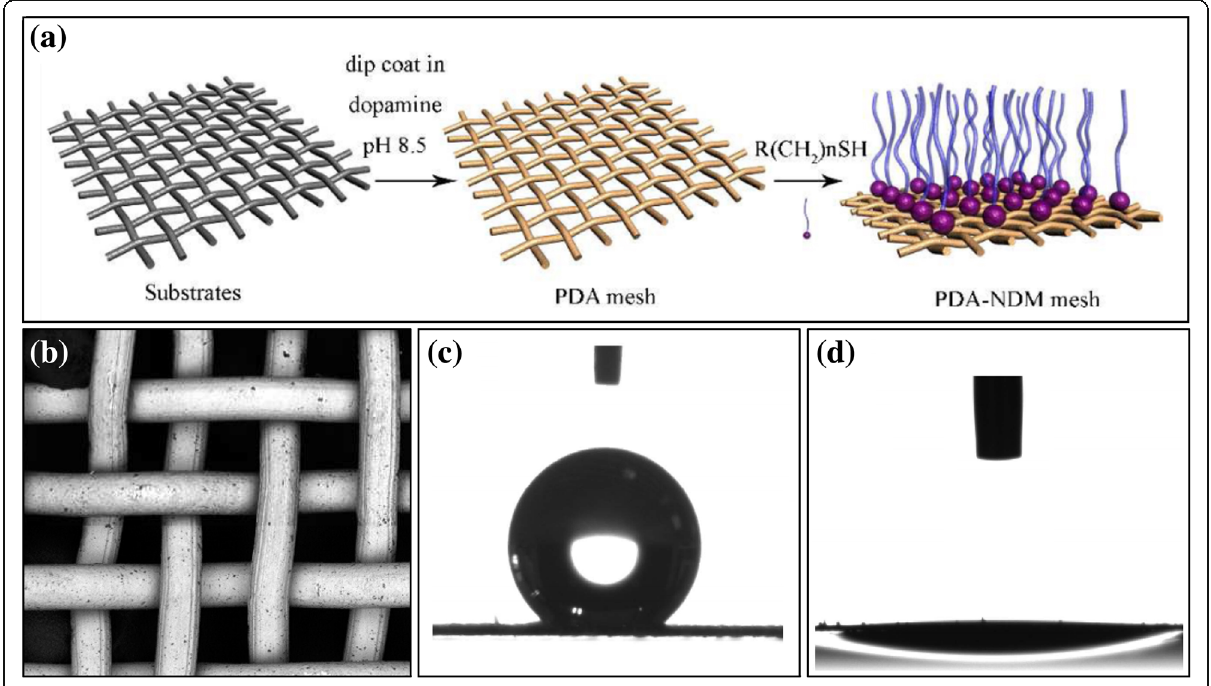
Fig. 3 a Schematic description of the preparation of polydopamine (PDA) coated stainless steel mesh film and N -dodecyl mercaptan (NDM) modified surface through Michael addition reaction [14]. b The low-magnification view of the PDA – NDM mesh with an average diameter [14] of approximately 40 μ m [14]. c The photograph of a water droplet (2 μ L) on the PDA – NDM mesh with a contact angle of 143.8 ± 1.0° [14]. d A diesel oil droplet (2 μ L) spreads and permeates quickly on the mesh